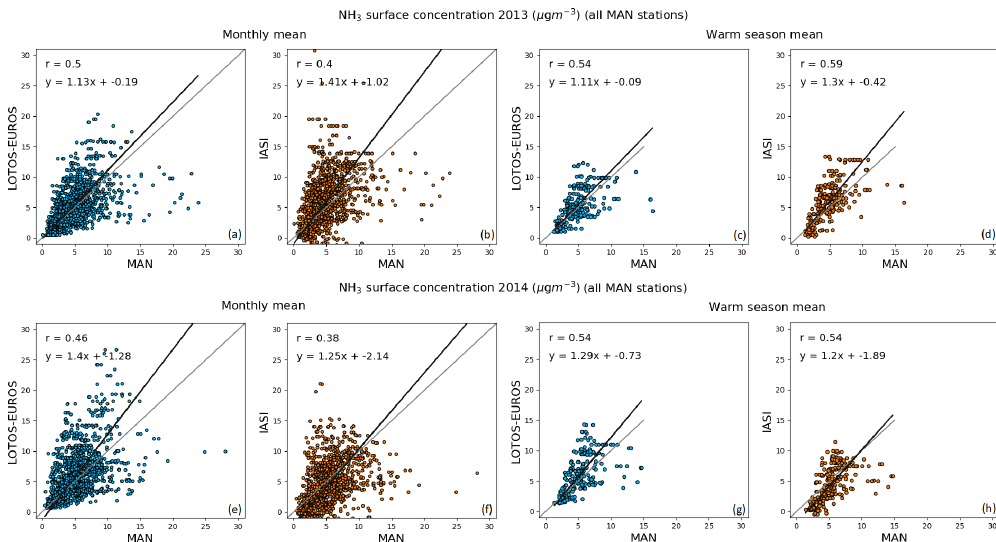
Figure 9. Comparison of the monthly mean (a, b, e, f) and warm season (April–September) mean (c, d, g, h) NH 3 surface concentrations measured by the MAN stations and the corresponding NH 3 surface concentrations from LOTOS-EUROS (blue dots) and inferred from IASI (orange dots) in 2013 (top) and 2014 (bottom).